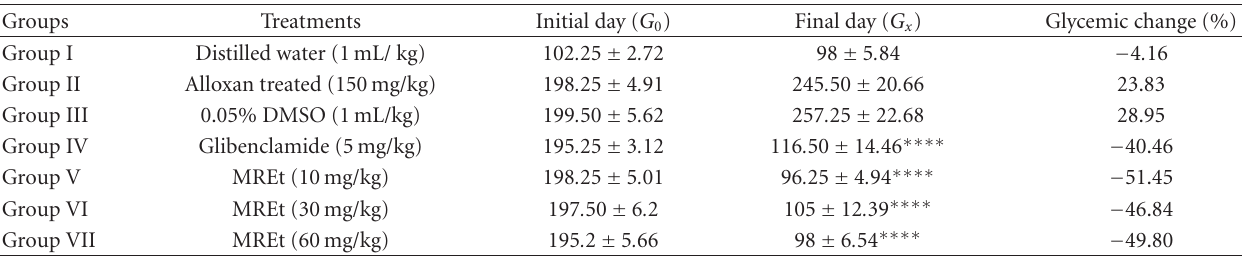
Table 3: E ff ect of MREt of R. serpentina on fasting blood glucose level in mice.